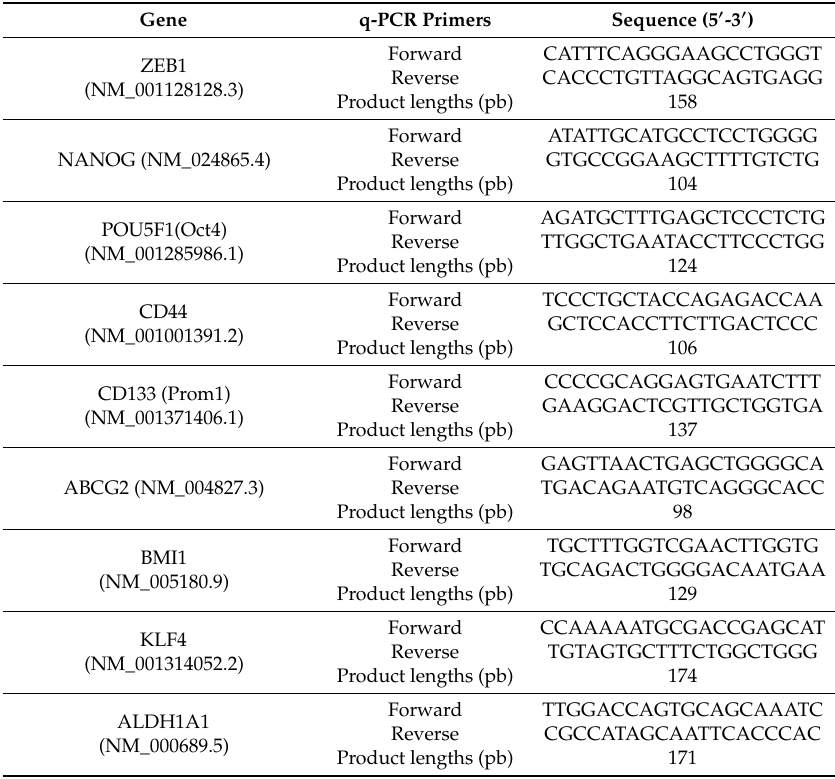
Table A1. Primers used for quantitative PCR